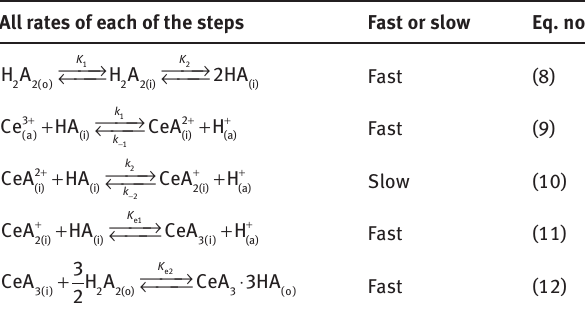
Table 1: The stepwise metathetical reaction mechanism for the extraction